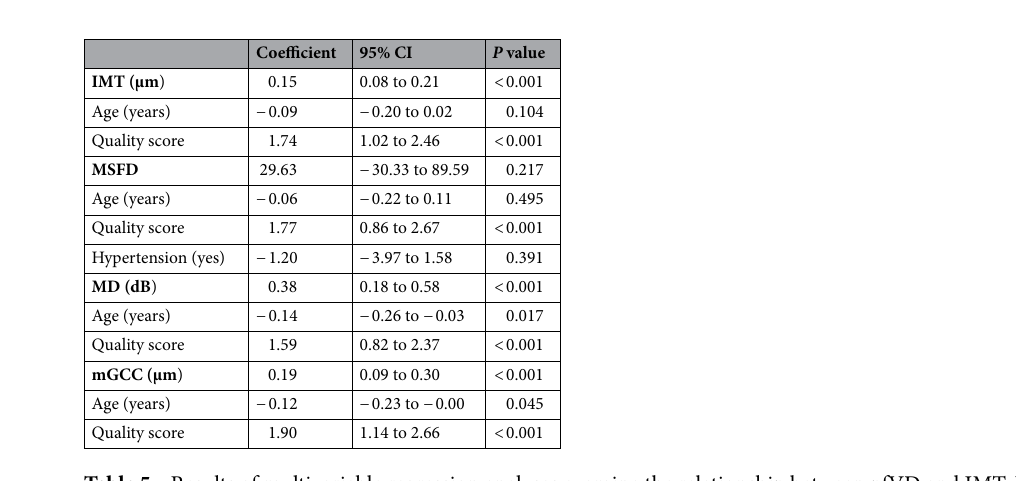
Table 5. Results of multivariable regression analyses examine the relationship between pfVD and IMT, MFSD, MD and mGCC, accounting for age, quality score and